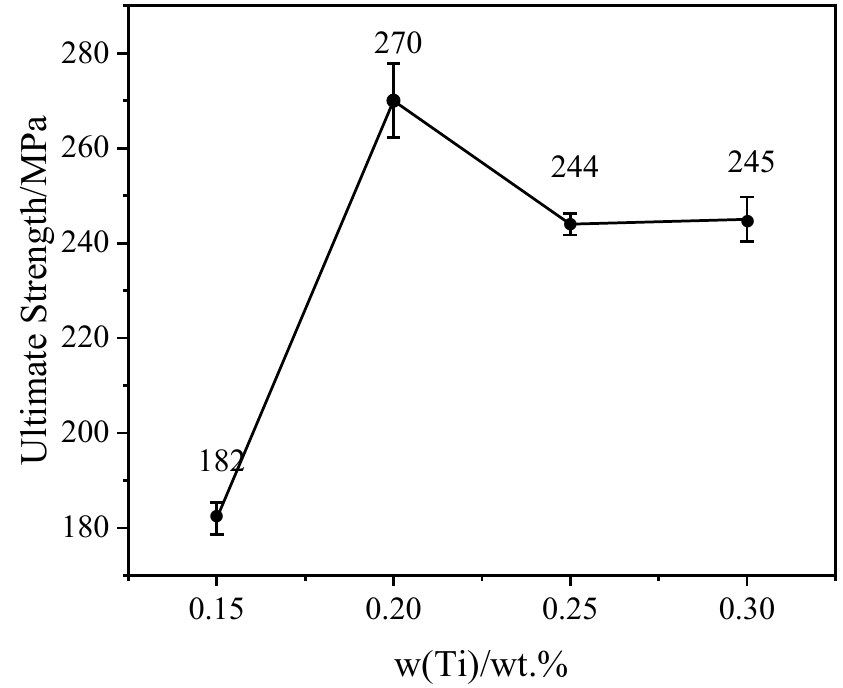
Figure 6. Tensile strength of GC samples with different Ti contents.